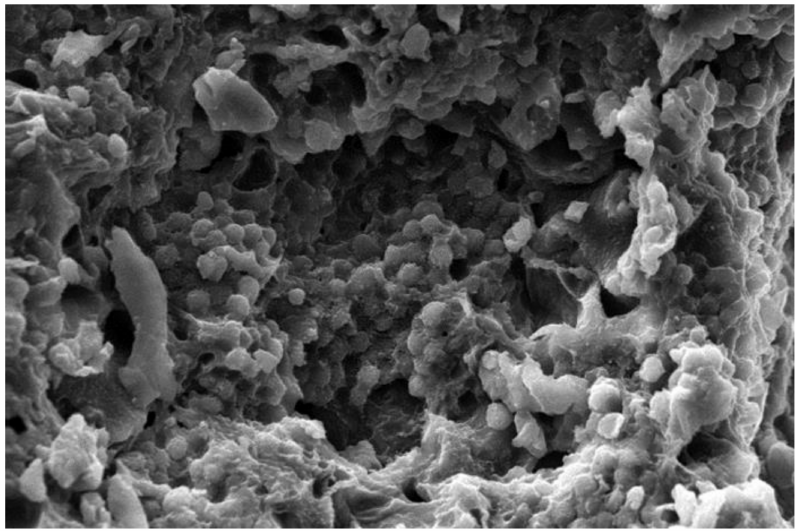
Figure 6. SEM image of TGP.